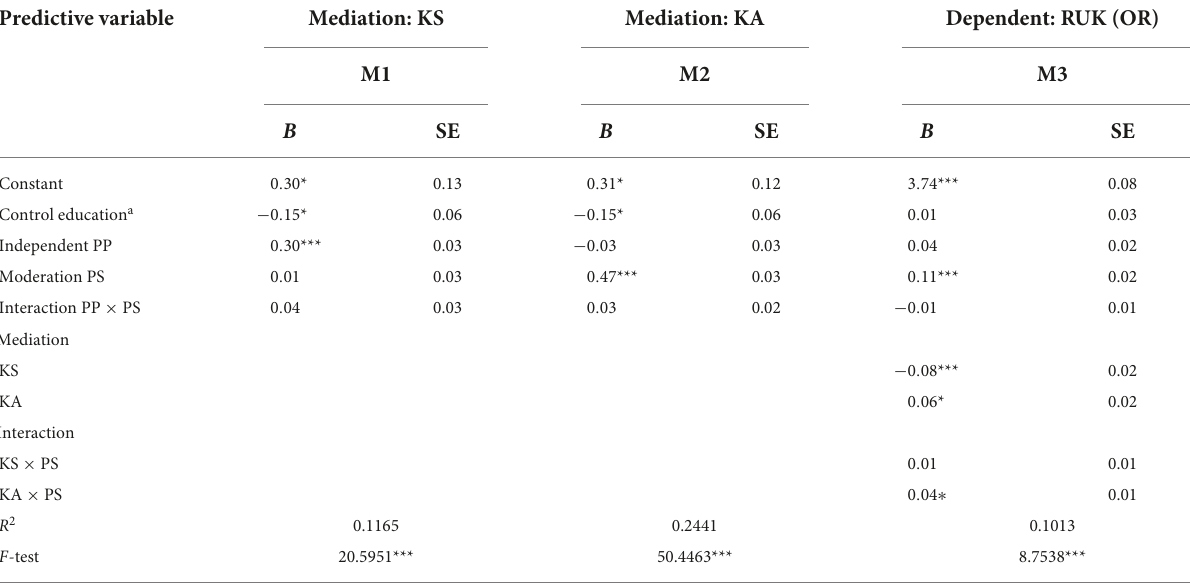
TABLE 6 Analysis of the moderating effect of political skills to partner protectiveness on receiving useful knowledge